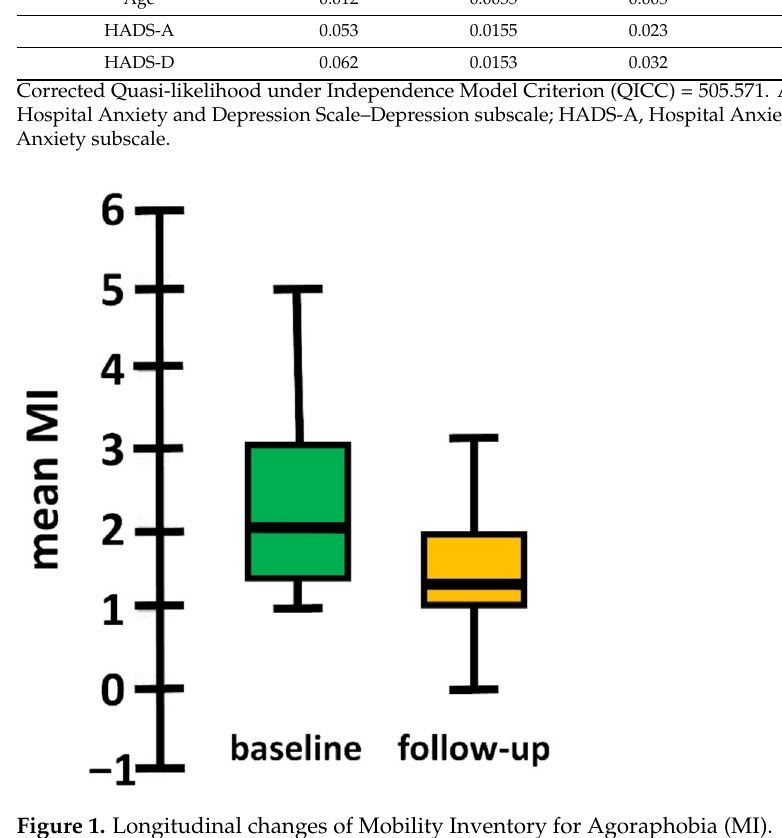
Figure 1. Longitudinal changes of Mobility Inventory for Agoraphobia